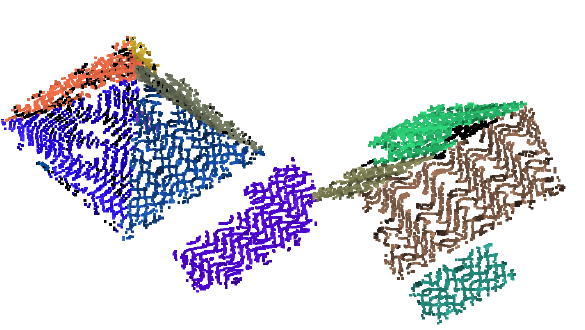
Figure 7: Illustration of all constraints between faces recognized by the hypotheses tests: identity ( −· ), orthogonality (–), paral- lelism ( · · · ), concurrence ( ◦ ), verticality (vertical poles). Con- straints with the bottom area of the building are omitted for clar- ity.